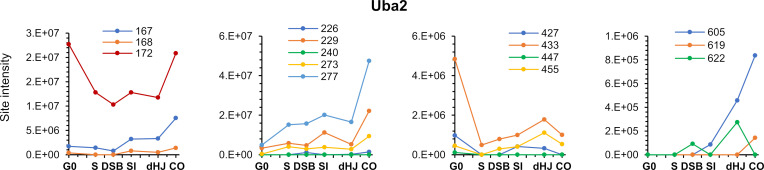
Diverse temporal profiles of SUMOylation sites on the SUMO E1 subunit Uba2.